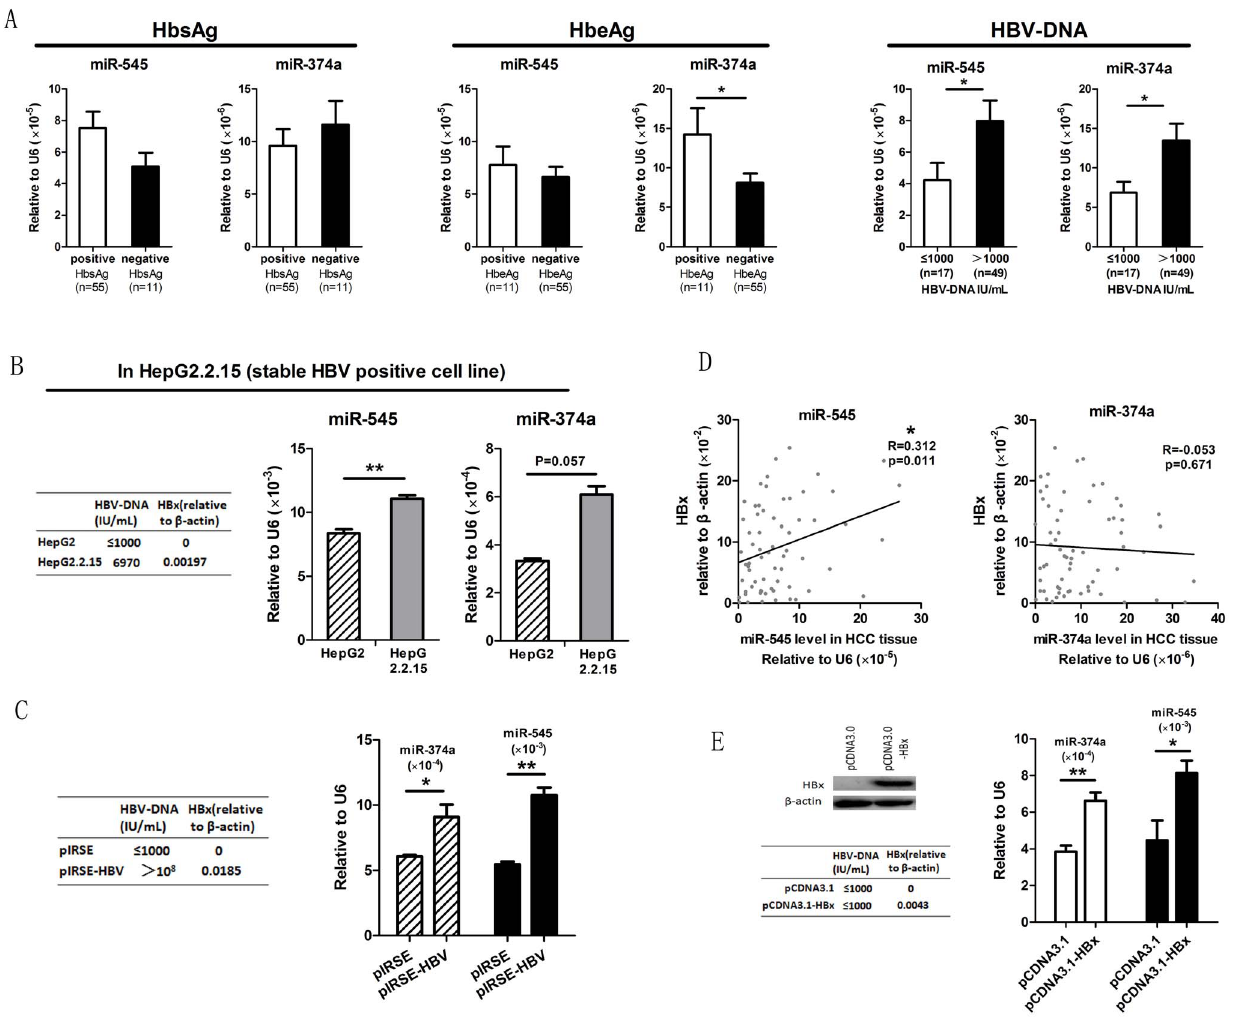
Figure 3. The influence of HBV infection on miR-545/374a cluster expression. (A) HCC subjects were grouped based on clinical HBV indices including HbsAg, HbeAg and HBV-DNA (Mean 6 Std.deviation, 10.64 6 9.158; Median, 7.035). The levels of miR-545 and miR-374a were determined by quantitative RT-PCR. Individual microRNA differences were measured by a student-t test between positive and negative groups. The error bars in A represent mean 6 Std. deviation. (B) Comparison of microRNA expression levels between the stable HBV positive cell line HepG2.2.15 and its parental HCC cell line HepG2. The levels of miR-545/374a were monitored by quantitative RT-PCR in both cell lines. The error bars in B represent mean 6 Std. deviation. (C) Analysis of microRNA expression levels in cells transfected with a HBV encoding plasmid. Cells were transfected with the HBV genome encoding plasmid (pIRSE-HBV) or the empty plasmid (pIRSE). To confirm the effective transfection of the HBV-genome containing plasmid we performed high-sensitive fluorescent quantitative PCR to detect HBV-DNA and quantitative real time PCR to detect HBx protein expression. The expression of miR-374a and miR-545 was measured by quantitative RT-PCR. *P , 0.05, **P , 0.01, independent t test. The error bars in C represent mean 6 Std. deviation. (D) Analysis of miR-545/374a and HBx expression levels in HBV HCC subjects. The levels of miR-545/374a and HBx mRNA were assayed by quantitative RT-PCR. *P , 0.05, Pearson’s correlation. (E) Analysis of miR-545/374a expression in HBx overexpressing cells. Bel-7402 cells were transfected with a plasmid expressing HBx (pCDNA3.1HBx) or with an empty plasmid (pCDNA3.1). Western blotting and quantitative RT-PCR were used to confirm HBx protein expression after transfection. The levels of miR-545/374a were assayed by quantitative RT-PCR. The error bars in E represent mean 6 Std. deviation. *P , 0.05, **P , 0.01, independent t test. MicroRNA 545 and miR-374a are both higher in male HCC patients compared to female HCC patients, and